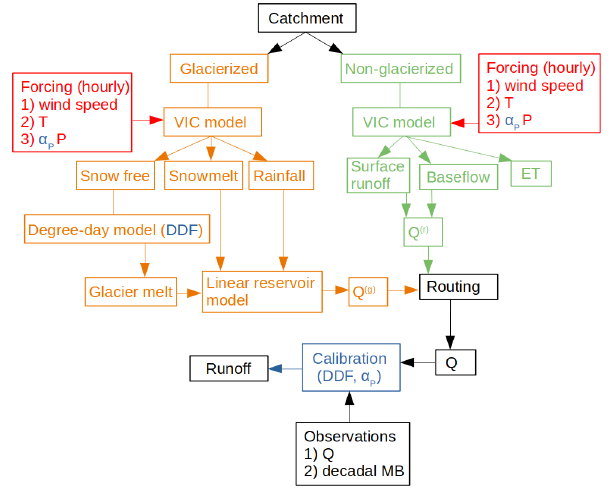
Figure 3. Flow chart of the glacio–hydrological model setup (see Sect. 3.2 for